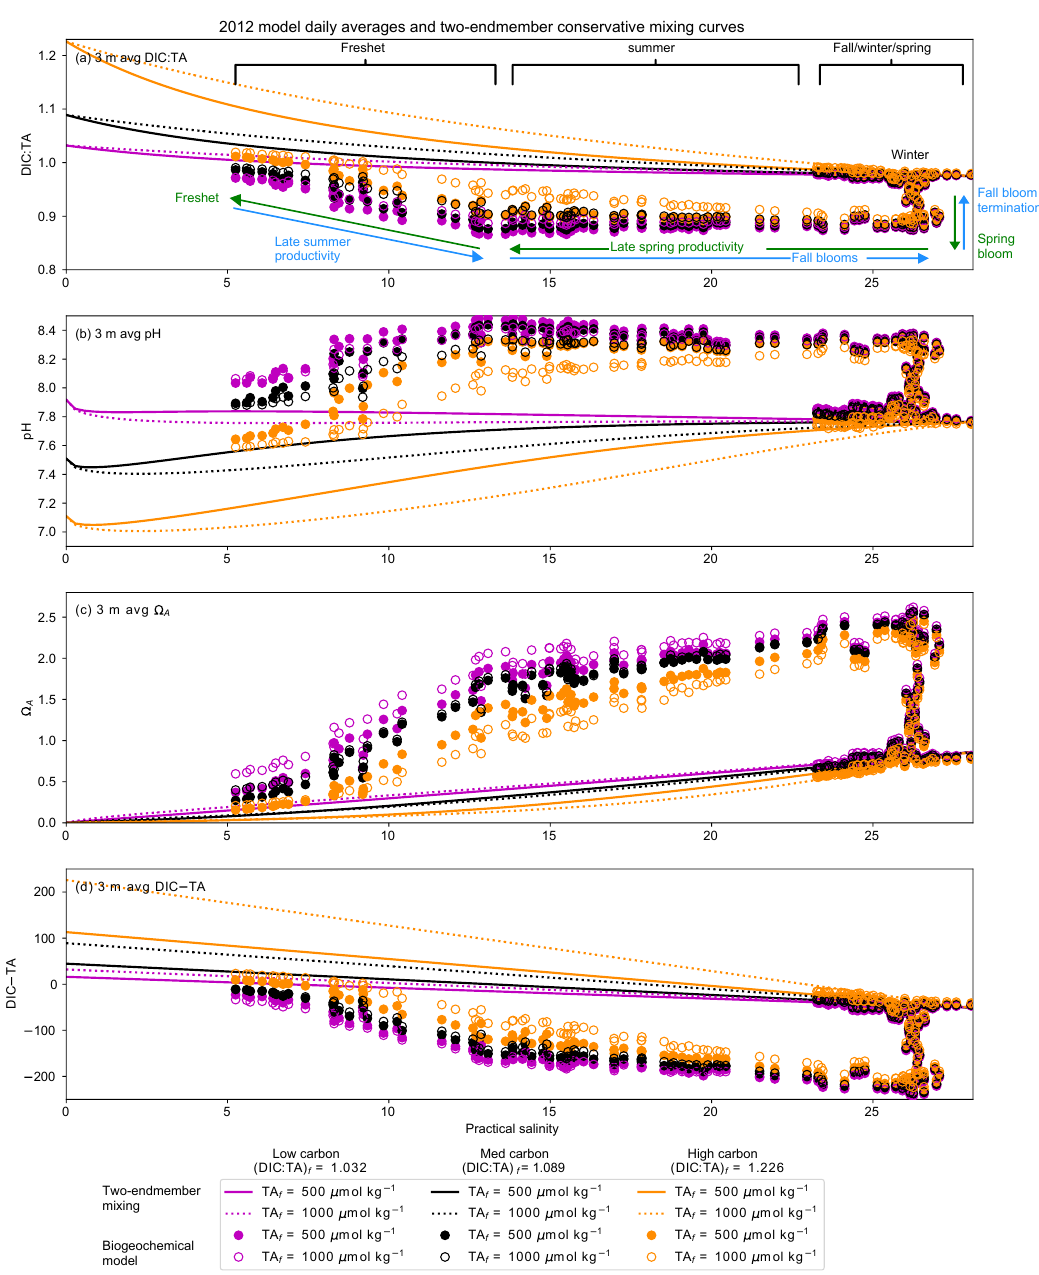
Figure 7. Daily model averages in salinity space during the largest freshet year (2012) of 3m averaged (a) DIC:TA, (b) pH, (c) (cid:127) A , and (d) DIC–TA under the Low Carbon (DIC f :TA f = 1.032, magenta circles), Med Carbon (DIC f :TA f = 1.089, black circles), and High Carbon (DIC f :TA f = 1.226, orange circles) scenarios during two constant TA f cases: TA f = 500µmolkg − 1 (filled) and TA f = 500µmolkg − 1 (open). Theoretical conservative mixing curves between the model freshwater and seawater endmembers (Table 1) calculated using CO2SYS are also shown (lines) for the corresponding DIC f :TA f and TA f cases as indicated by color and line style, respectively (see legend). All runs demonstrate significant divergence from the theoretical curves during spring and summer while converging toward the freshwater endmember at low salinity during the freshet and toward the seawater endmember at high salinity during winter, as indicated by the annotations in (a) . Differences between TA f cases in the model are otherwise similar to the conservative mixing cases; however, the effect of DIC f :TA f in the model is reduced relative to the mixing